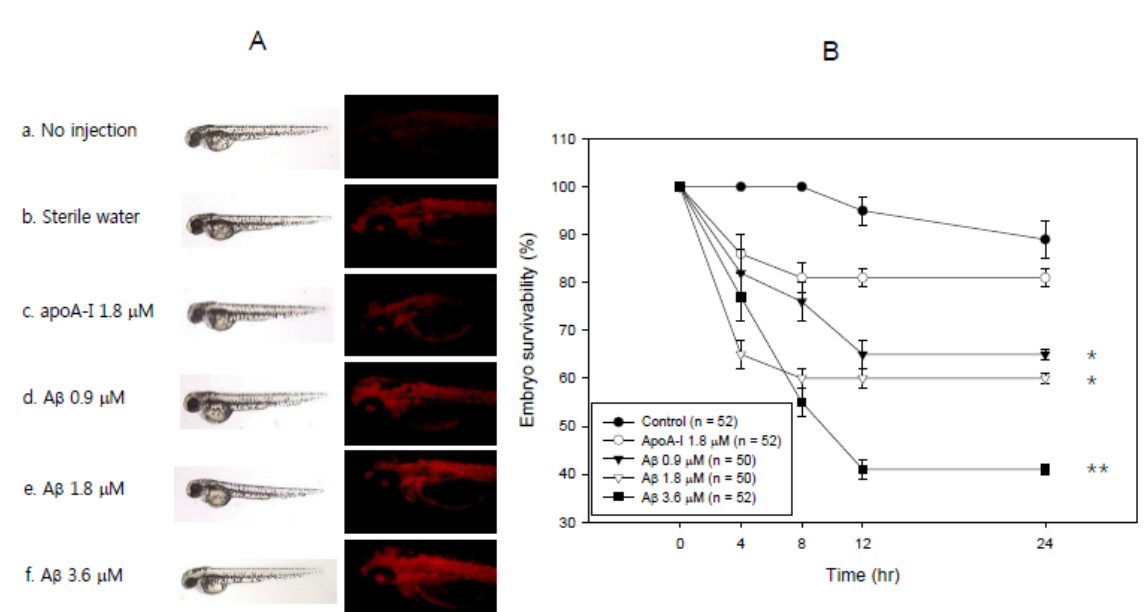
Figure 8. Comparison of the toxicity to embryos between apoA-I and Ab in zebrafish embryo. ( A ) Developmental status of embryo and visualization of ROS by DHE staining. ( B ) Survivability of embryos during the 24 h post-injection with apoA-I or A β . *. p < 0.05; **, p < 0.01 compared with apoA-I at 24 h incubation time.